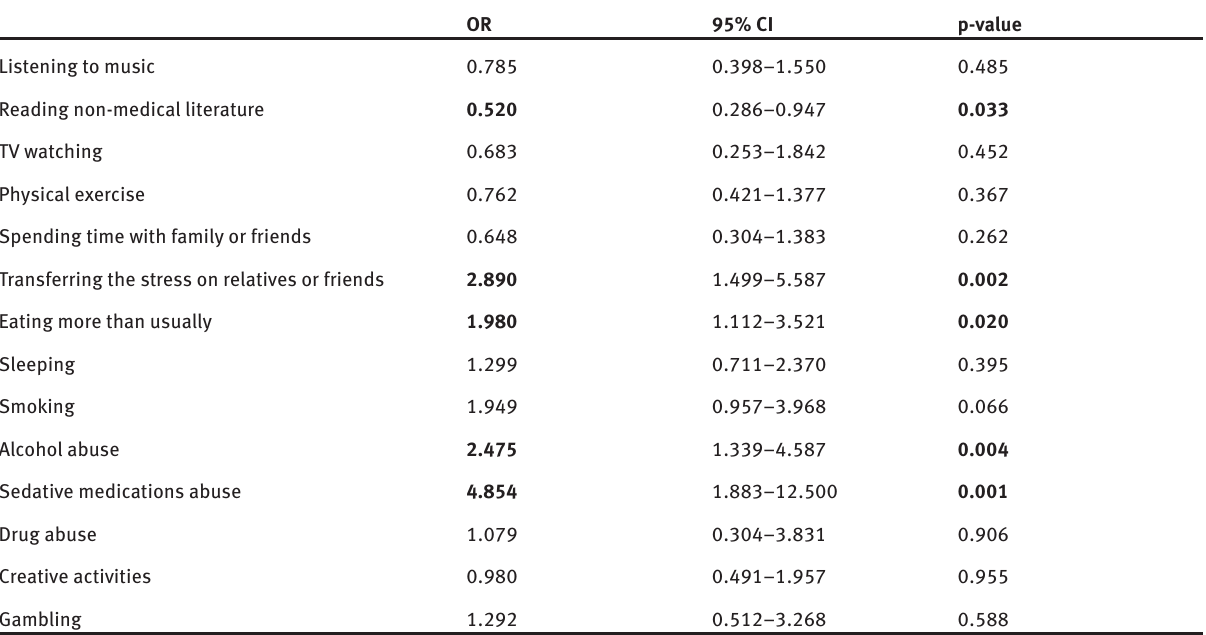
Table 7: Associations between favorite after-work activities and professional